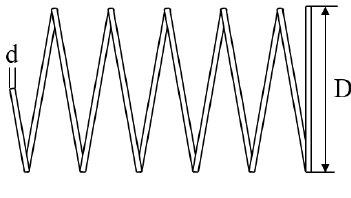
Figure 12. Sping design problem. Table 10. Results of spring design problem for different